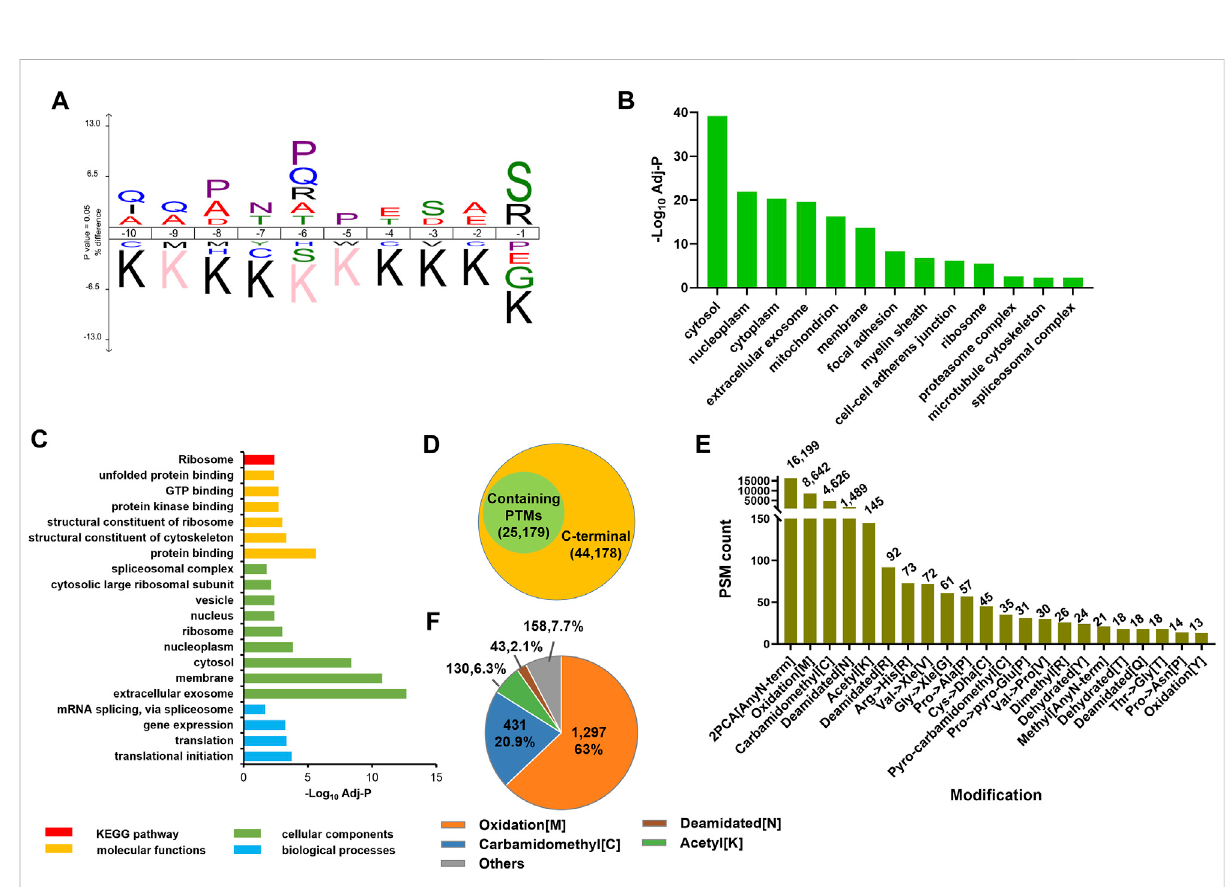
FIGURE 5 Function analysis oftheenriched C-terminal truncated proteins andthePTM distributiononC-terminalpeptide. (A) IceLogo analysisofthelast 10 amino acids of original C-terminal identi fi ed by PBC strategy. (B) Cellular components enrichment analysis of C-terminal proteins identi fi ed by PBC strategy. (C) The gene ontology and KEGG pathway enrichment analysis of the proteins with C-terminal truncated. The truncated proteins signi fi cantlyenrichedinextracellularexosome,vesicle,andribosome. (D) Piechartanalysisofidenti fi edPSMwithandwithoutcontainingPTMs. In total, more than 30% PSM were identi fi ed with PTM-labeled peptides. (E) Distribution of PTMs modi fi ed on C-terminal peptide. (F) Distribution of identi fi ed PTMs on last amino acid of protein